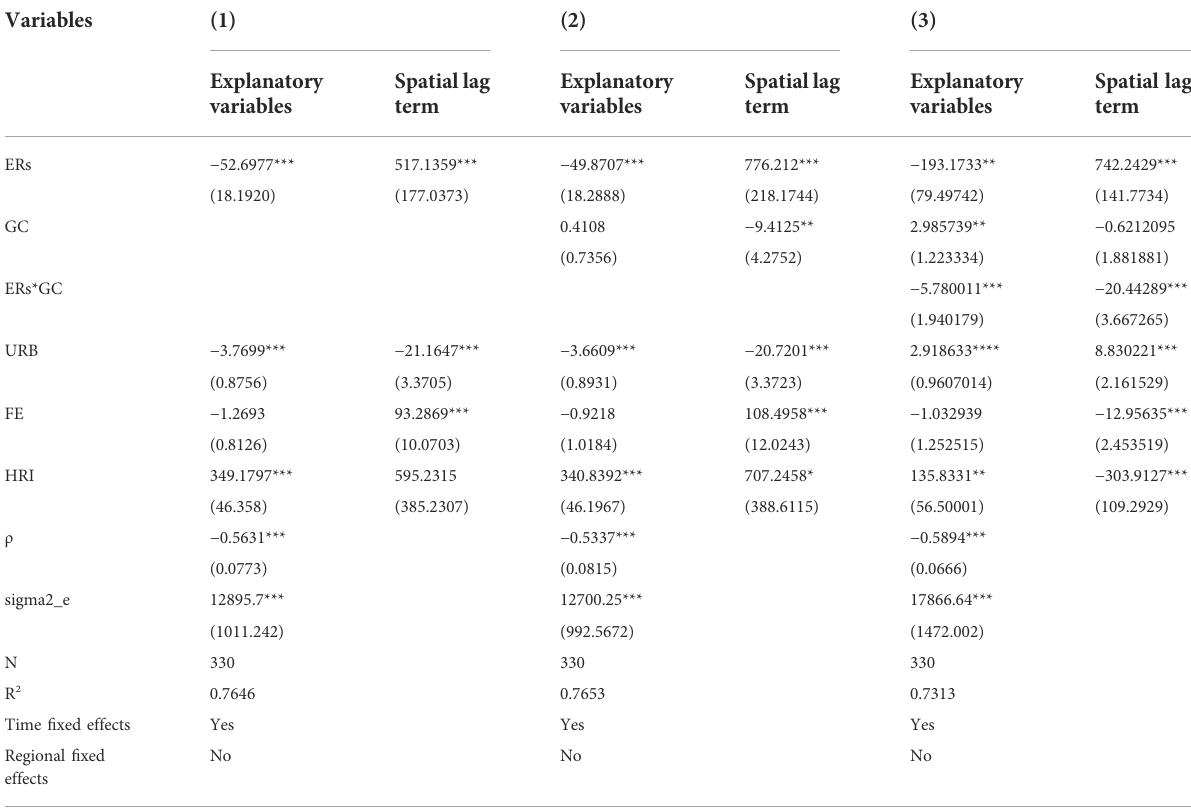
TABLE 2 Baseline regression